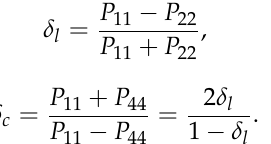
Figure 9. The exact backward scattering ( P 11 (180°)) ( a ) and its partial derivatives with respect to wavelength ( b ) and effective radius ( c ) for size parameters of 1 – 500 and wavelengths of 0.4 – 15 μ m. The dashed line in (c) represents the division of positive and negative derivatives.